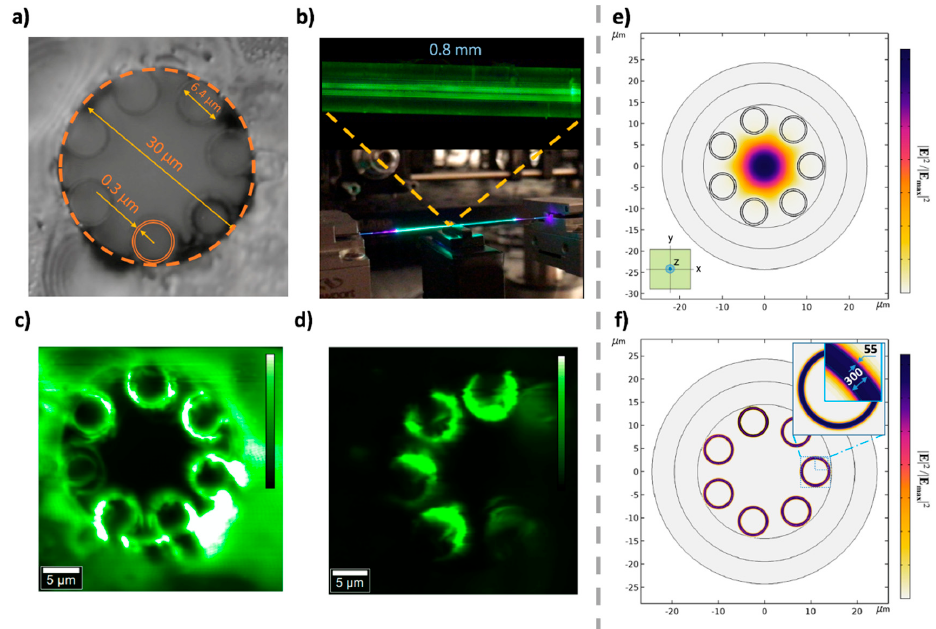
Figure 3. ( a ) Cross section of an undoped fiber taken with optical microscopy; ( b ) picture of the whole doped HC-NCF being pumped with the 405 nm CW laser and zoomed axial fragment (this image was registered with an optical microscope that assists the experimental setup described in Figure 2). ( c , d ) PL cross-section images at input and intermediate (after cleaving) faces of the HC-NCF, respectively; ( e ) simulation of the modal field distribution of the seven-tube HC-NCF fiber operating at a wavelength of 515 nm in the absence of PNCs. Z-axis corresponds to the propagation direction; and ( f ) modal field distribution of the HC-NCF doped with PNCs concentrated on the tube walls after considering a PNC layer with 55 nm thickness.